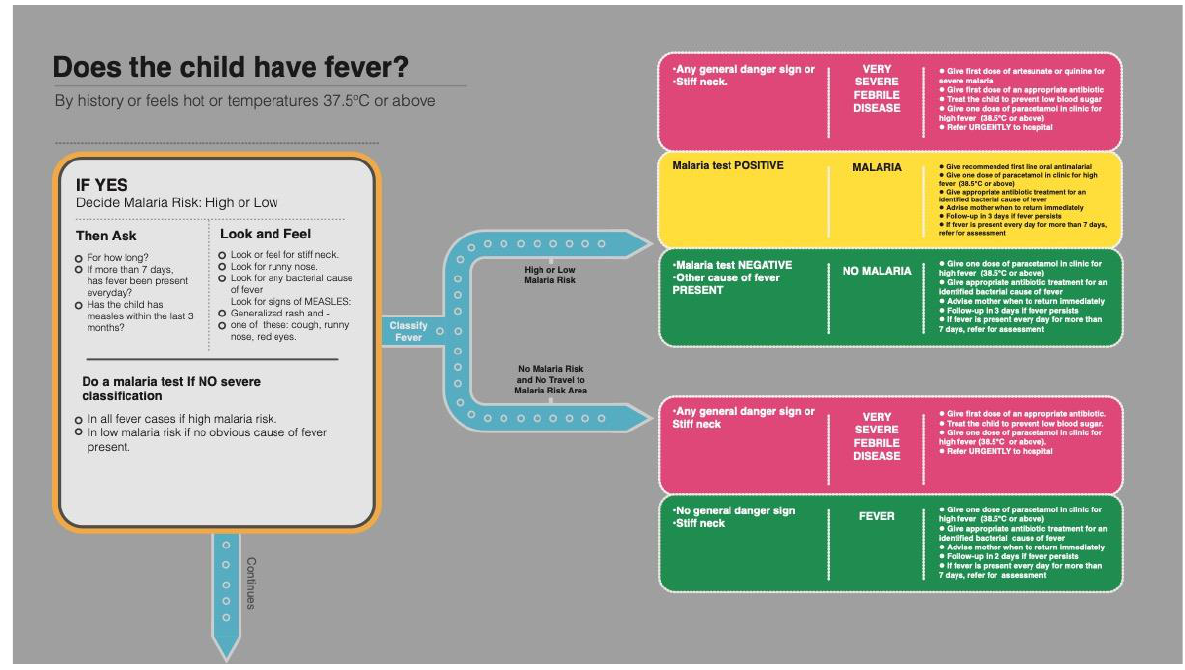
Figure 3. Fever algorithm from the 2014 IMCI chart booklet. Reprinted from Integrated Management of Childhood Illness Chart Booklet , 3rd ed., WHO and UNICEF, page 4, copyright 2014. Accessed 1 October 2018.